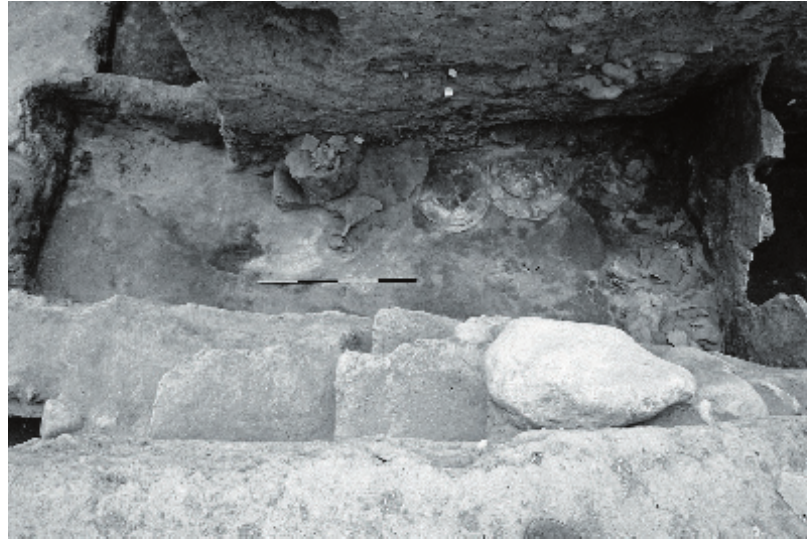
Figure 2. Scullery (Early Bronze Age, 2750 B.C.), Tell es- Sa’idiyeh, Jordan, with finds in situ. Courtesy of Jonathan Tubb, British